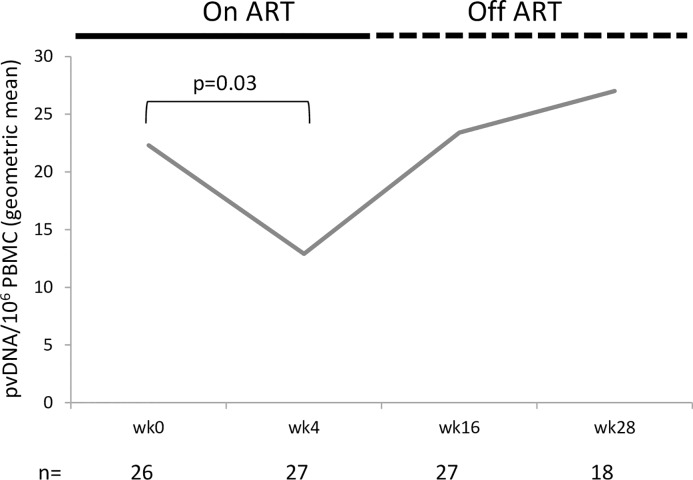
Geometric mean of proviral DNA (pvDNA) levels per million peripheral blood mononuclear cells (PBMC) in the per protocol population.One participant lacked pvDNA data from week 1. p-value was derived from a non-parametric Wilcoxon signed-rank test.